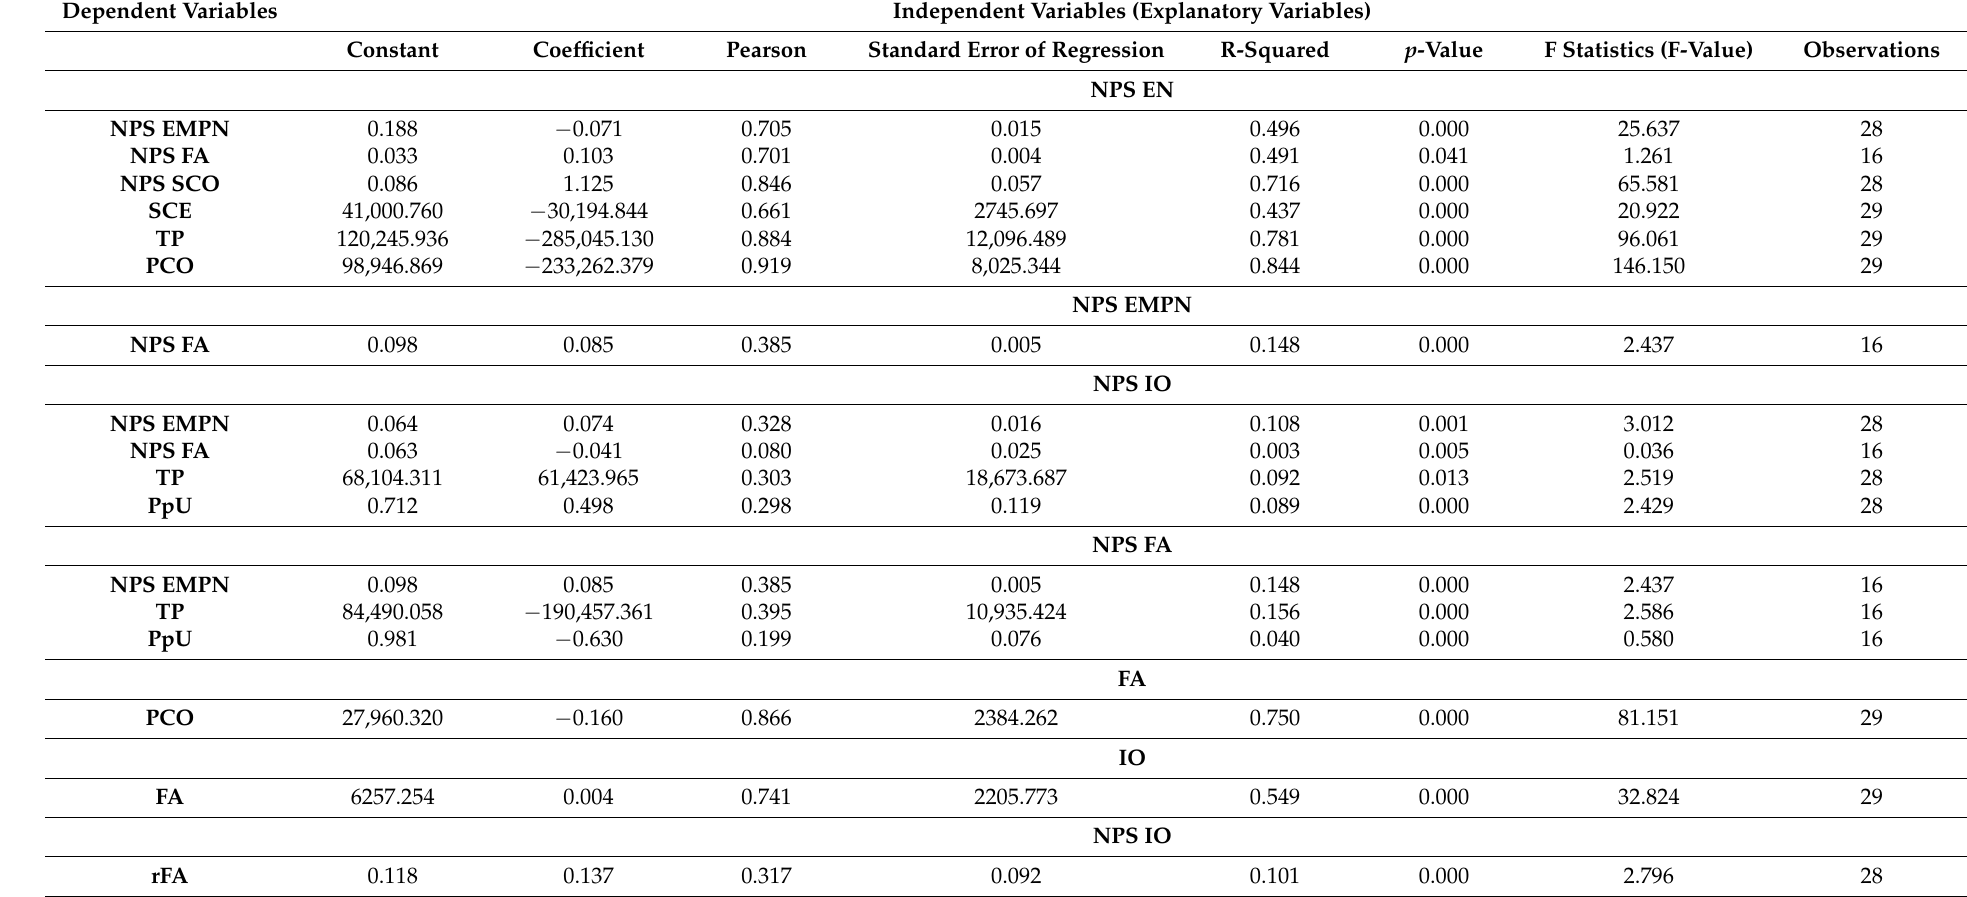
Table A6. Results of the univariate regression analysis (significant results